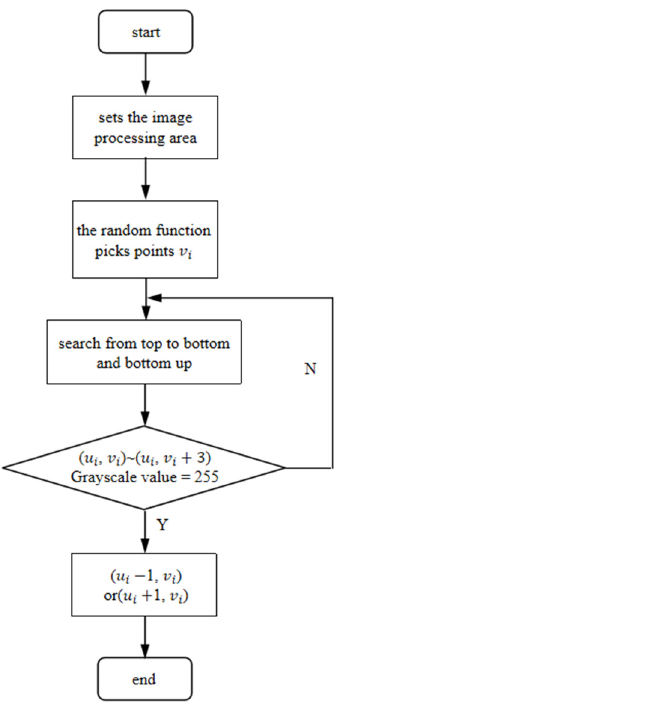
Figure 7. Flow chart of the secondary adaptive image processing